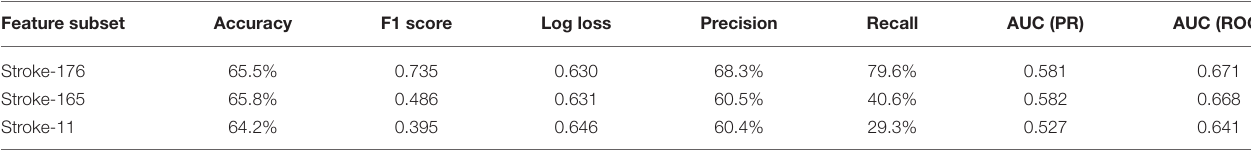
TABLE 3 | Results of the AutoML experiments for cognitive test performance classification with different feature subsets used for training. Feature subset